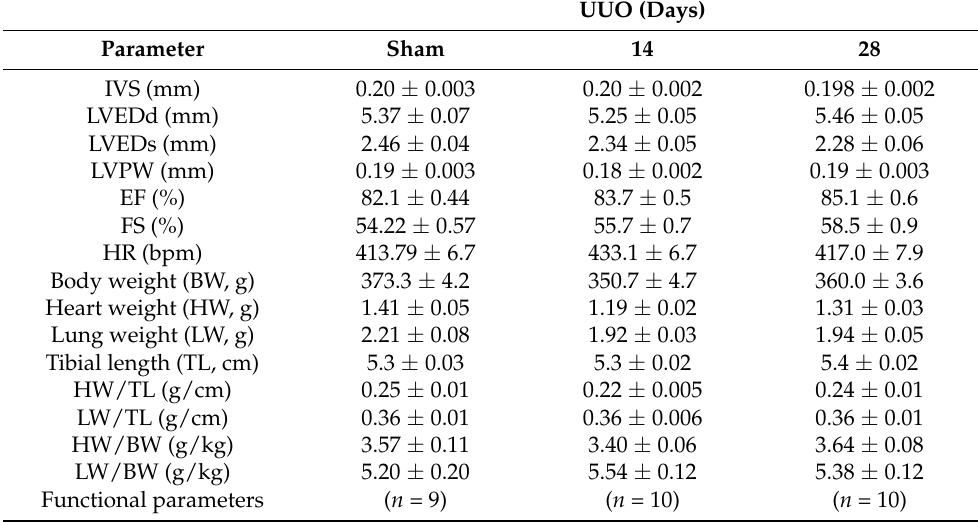
Table 1. Cardiac structural and functional parameters in rats subjected to unilateral ureteral ob- struction (UUO) for 14 and 28 days. Data are the mean ± SEM of 9–10 different animals in each experimental group. IVS: interventricular septum; LVEDd: LV dimension at end-diastole; LVEDs: LV dimension at end-systole; LVPW: LV dimension posterior wall, EF: ejection fraction; FS: fractional shortening; HR: heart rate; bpm: beats per minute. UUO